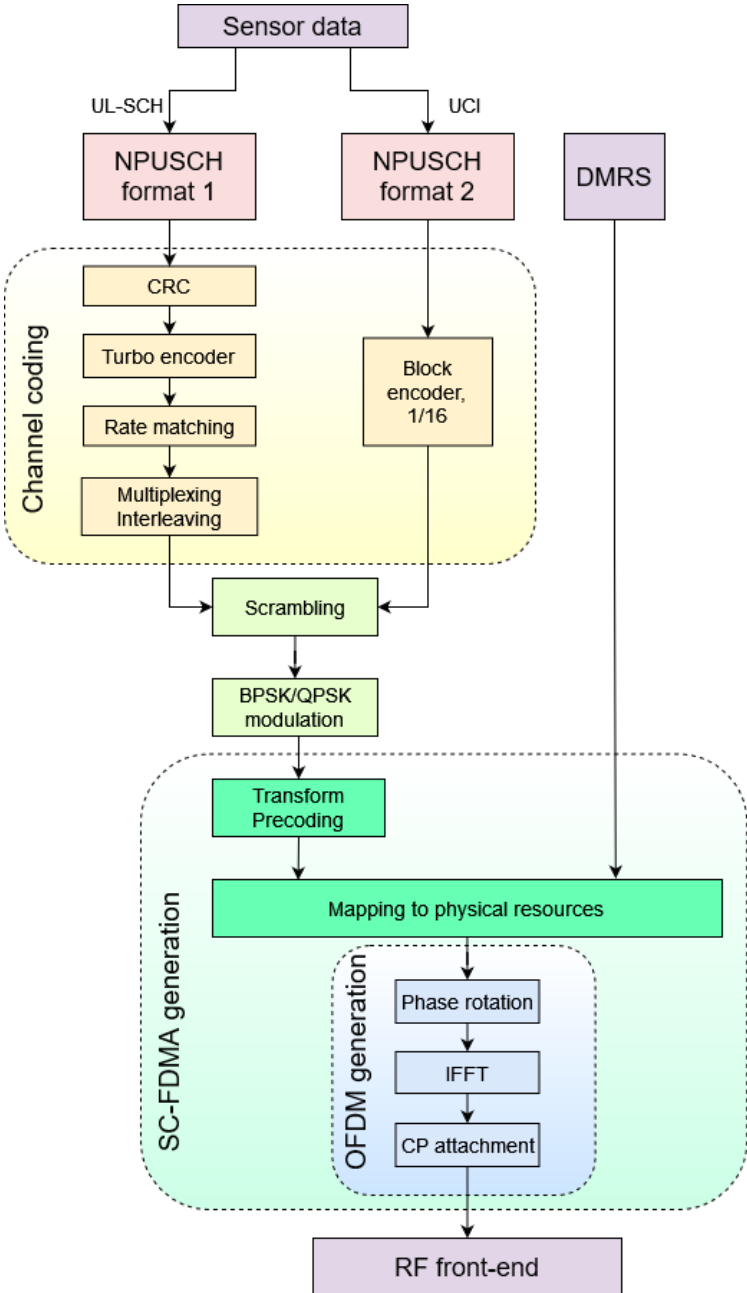
Figure 2. NB-IoT uplink modular procedures